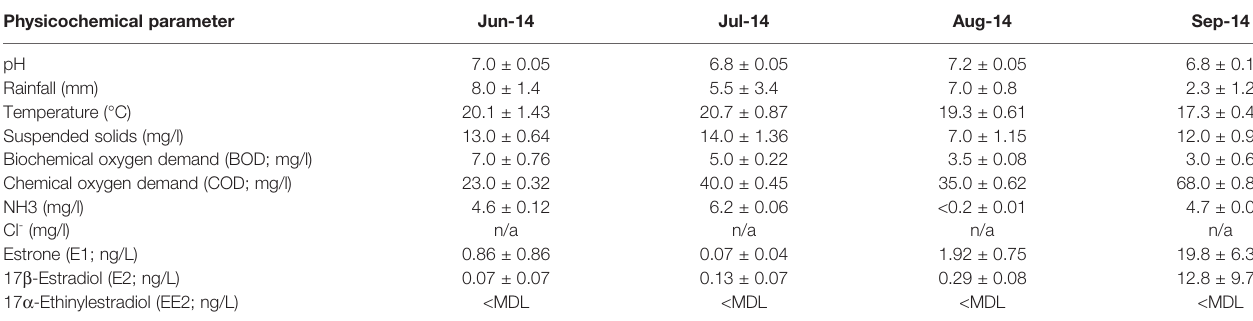
TABLE 1 | Physiochemical parameters measured for the treated wastewater ef fl uent collected from the WwTW during the different experimental periods. Physicochemical